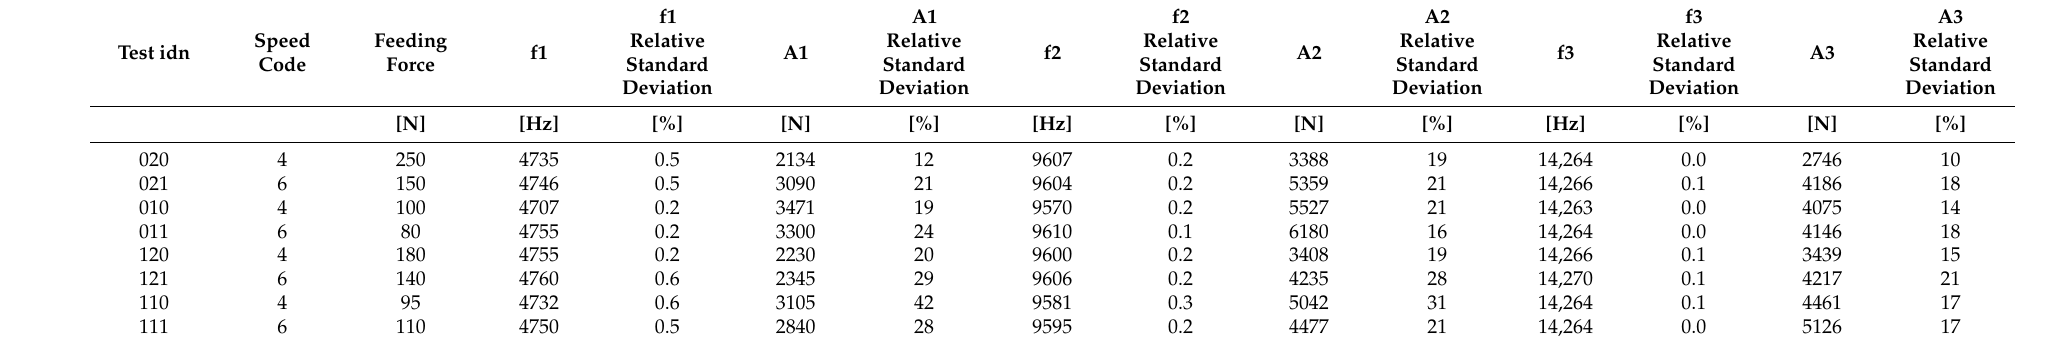
Table 5. Measured frequencies and amplitudes for the axial force.